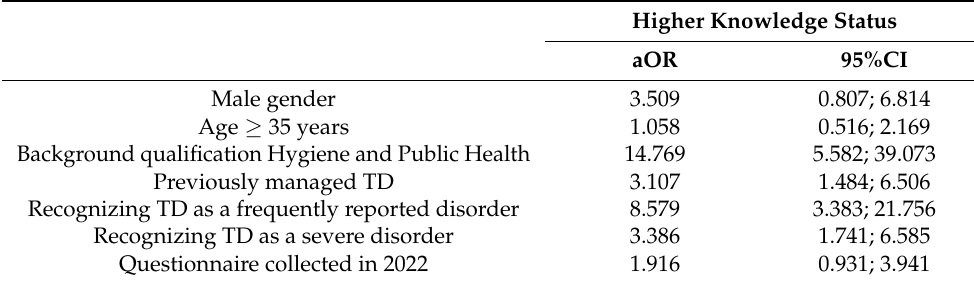
Table 4. Multivariate analysis of factors associated with higher knowledge status. The model included all variables that, in univariate analyses, were associated with a better knowledge score having p < 0.05 alongside a subset of factors that were included “a priori” (gender, age, having previously managed TD cases, and having completed the questionnaire in